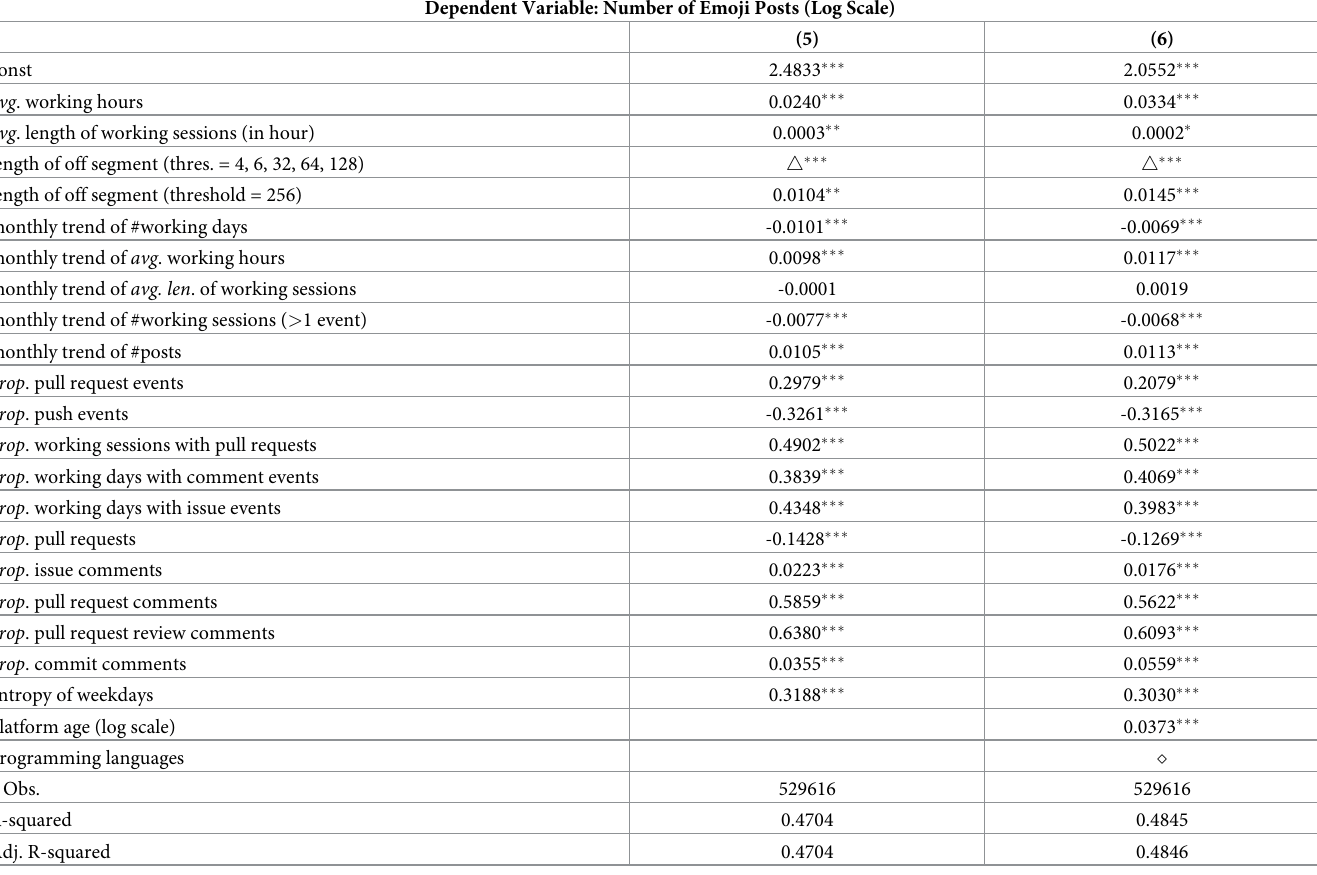
Table 2. OLS regressions of emoji usage on working status. Multiple working status measures are significantly related to emoji